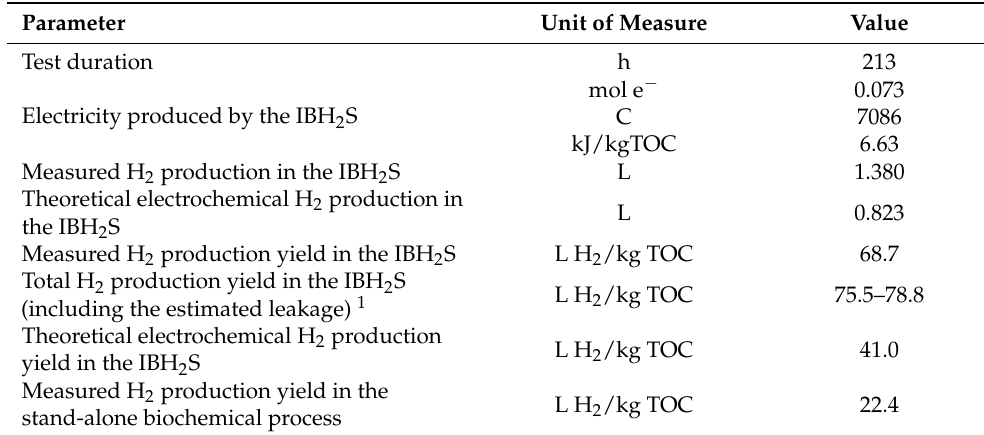
Table 4. Main results for the IBH 2 S (stage